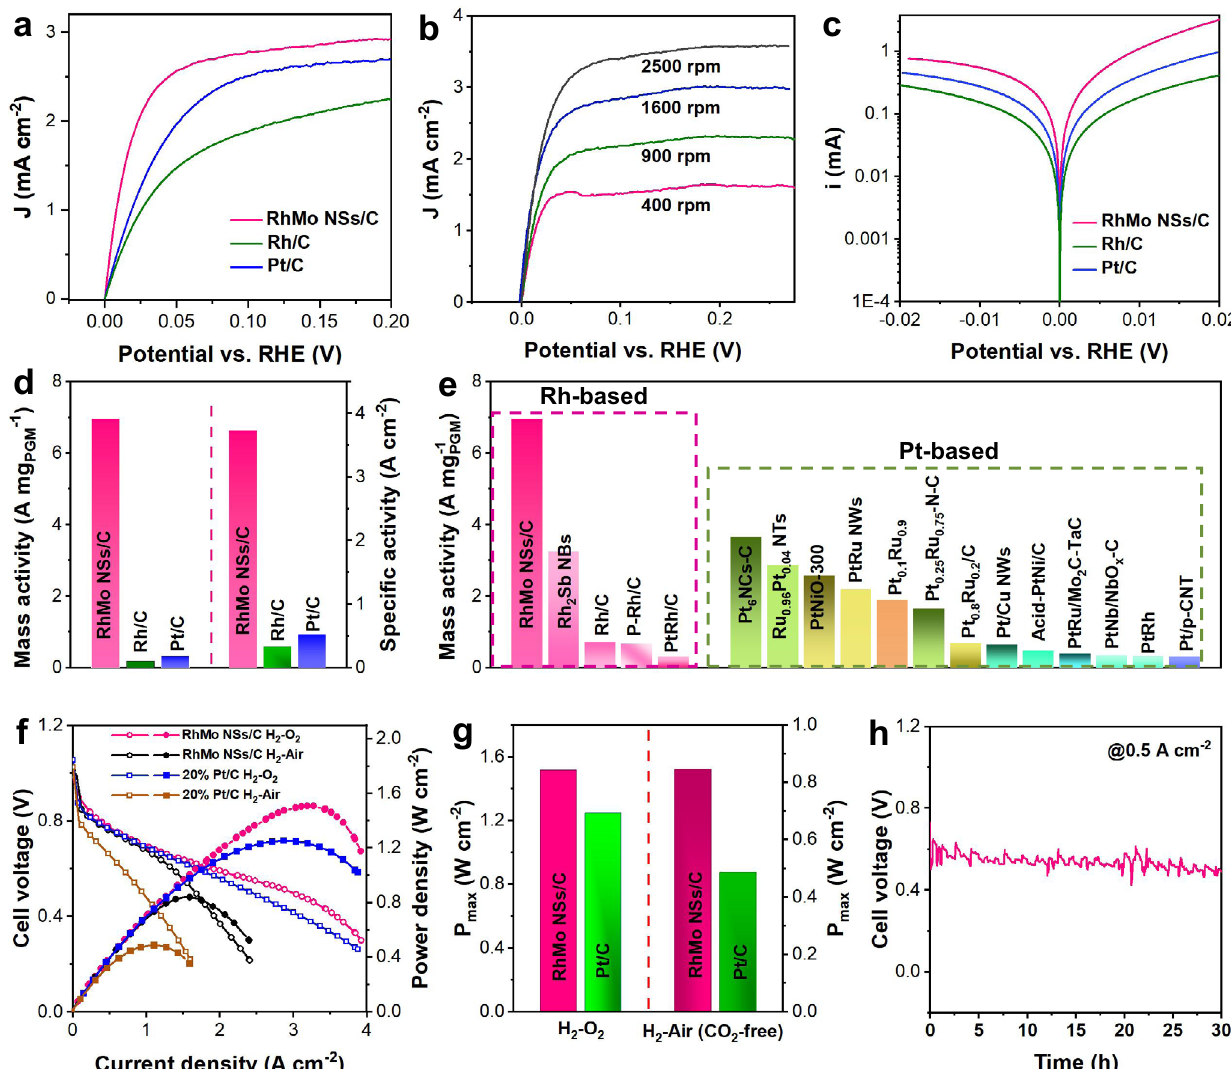
Fig. 3 | HOR and MEA evaluations of RhMo NSs. a HOR polarization curves of RhMo NSs/C, Rh/C, and Pt/C in 0.1M KOH with a scan rate of 5mVs − 1 at a rotation speed of 1600 rpm. b HOR polarization curves of RhMo NSs/C with different rotation speeds. c Tafel slopes of RhMo NSs/C, Rh/C, and Pt/C. d Mass and speci fi c activities of RhMo NSs/C, Rh/C, and Pt/C. e Comparison of the mass activity of RhMo NSs/C and previously reported electrocatalysts at an overpotential of 50mV in 0.1M KOH. f Polarization curves and peak power